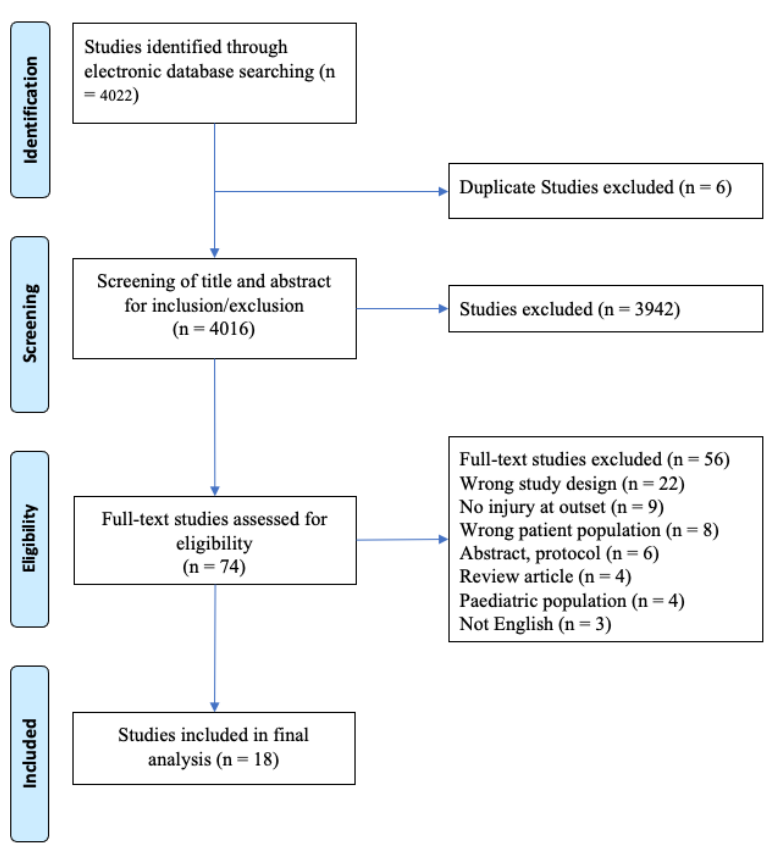
Figure 1. PRISMA flow diagram of the selected papers.